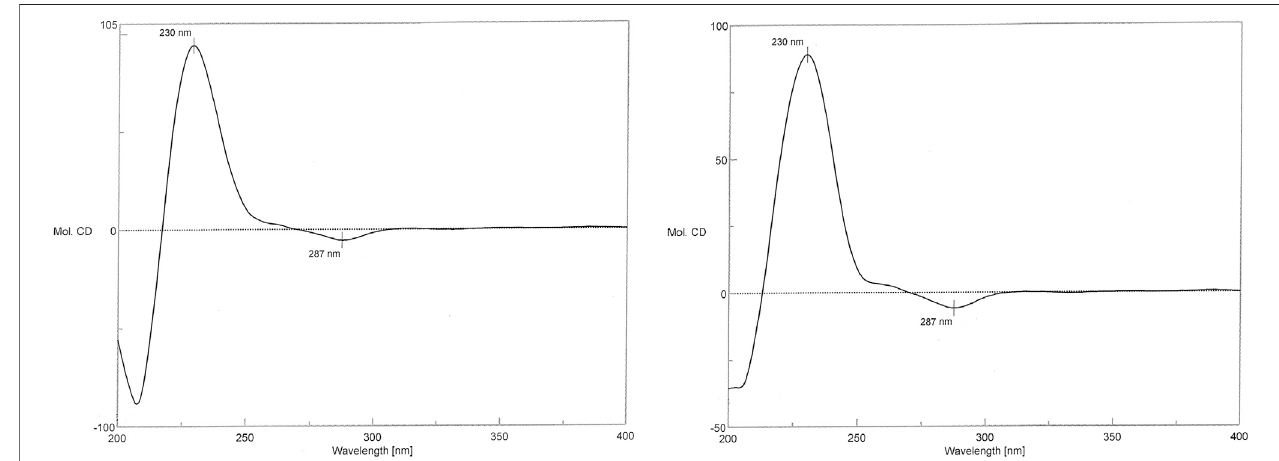
FIGURE 7 | CD spectra of 1 and the reference